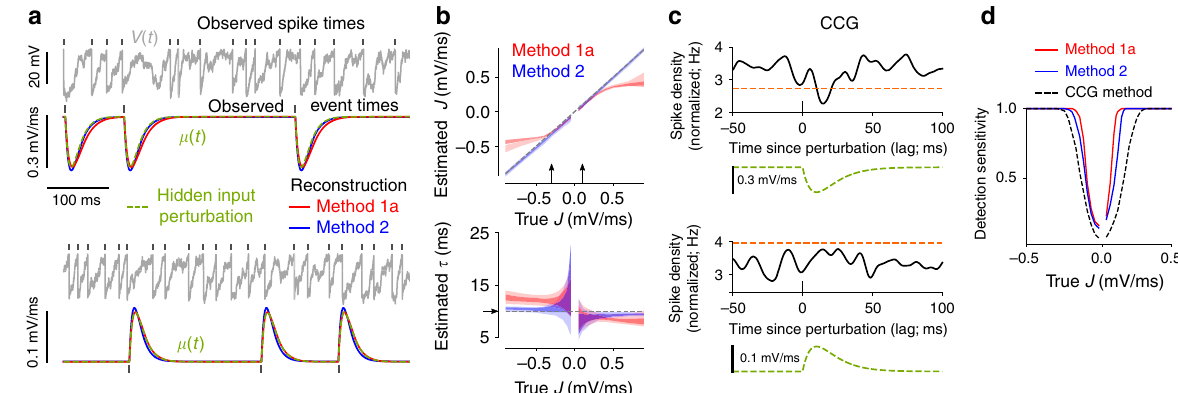
Fig. 3 Estimation results for input perturbations using synthetic data. a Example membrane voltage and mean input time series (true and reconstructed ones using the estimated parameter values) for weak excitatory (lower panel) and somewhat stronger inhibitory (upper panel) perturbations. Methods 1a and 2 were used for parameter estimation. b Central 50% (i.e., 25 – 75th percentile) of estimates for J and τ as a function of true J for two spike train lengths (100 s, light shade; 500 s, dark shade). Arrows indicate the parameter choices in ( a ). c Normalized CCGs (i.e., spike density curves aligned to perturbation onset times) with signi fi cance threshold (orange dashed line) for the indicated mean input perturbations, corresponding to the examples in ( a ). The CCGs are normalized such that their integral over all lags equals one. d Detection sensitivity as a function of J computed from the estimation methods (solid lines) or using CCGs (dashed line) based on spike trains of length 100 s (cf. c ). For details see Methods section “ Modeling input perturbations